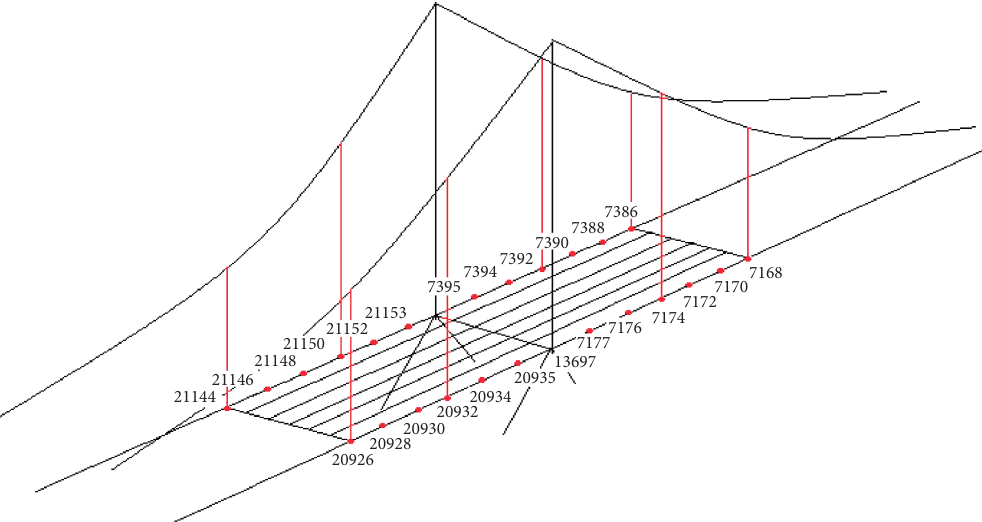
Figure 6: The most unfavorable beam diagram.